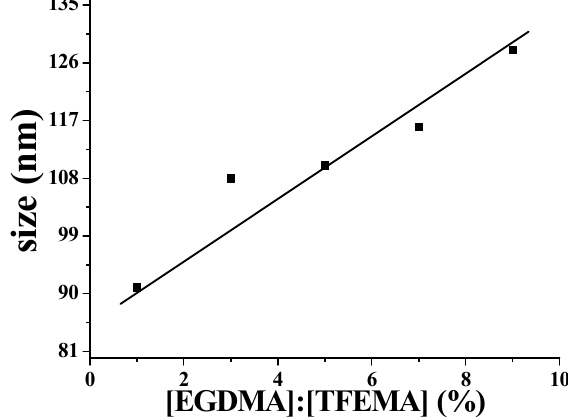
Figure 8. Relationship between particle size and amount of EGDMA added during RAFT-mediated polymerization. Polymerization conditions: macro-RAFT agent:[TFEMA] = 1:700, macro-RAFT agent:[APS] = 3:1, 70 °C, 120 min.